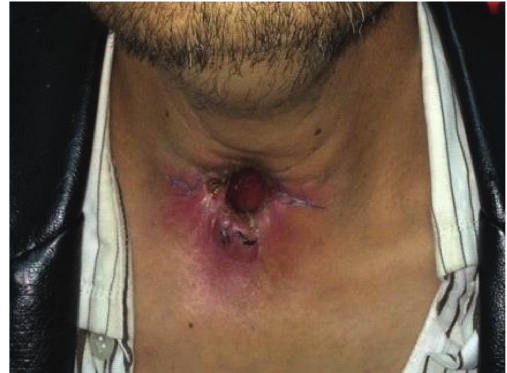
Figure 4: Three weeks after TLM-TL, compared to the conven- tional total laryngectomy, the aesthetic results are better, and there are no signs of pharyngocutaneous